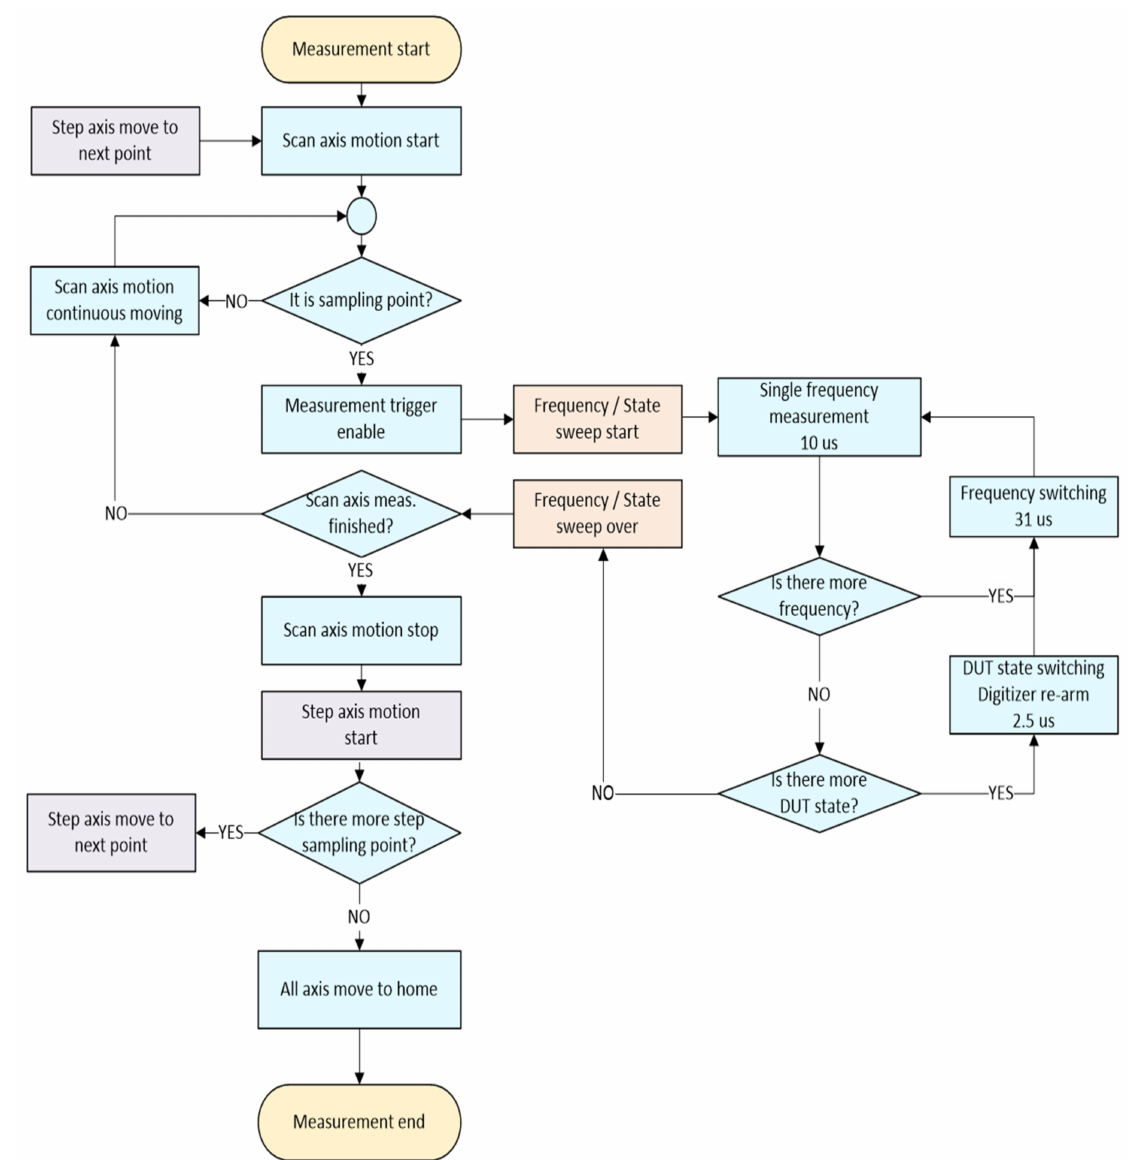
Figure 7. General scheme of the measurement